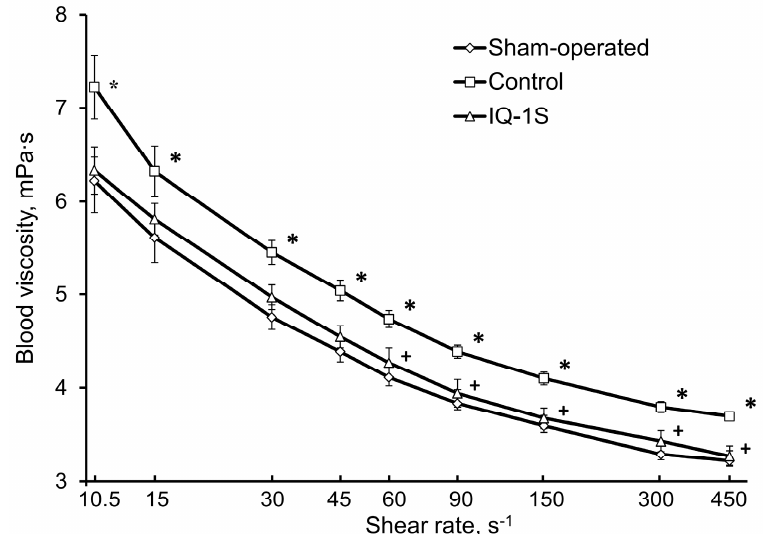
Figure 5. E ff ects of IQ-1S (50 mg / kg, i.g.) on the viscosity of whole blood (mPa · s) in rats at day 5 after GCI. * p < 0.05 as compared with the sham-operated animals; + p < 0.05 as compared with the control. Figure 5. Effects of IQ-1S (50 mg/kg, i.g.) on the viscosity of whole blood (mPa·s) in rats at day 5 Table 4. The e ff ects of IQ-1S (50 mg / kg, i.g.) on plasma viscosity, hematocrit (Ht), and parameters of after GCI. * р < 0.05 as compared with the sham-operated animals; + р < 0.05 as compared with the erythrocyte aggregation in the shear flow (Ct and Cs) in rats at day 5 after GCI. control. Table 5. The effects of IQ-1S (50 mg/kg, i.g.) on the erythrocyte elongation index in rats at day 5 after GCI.